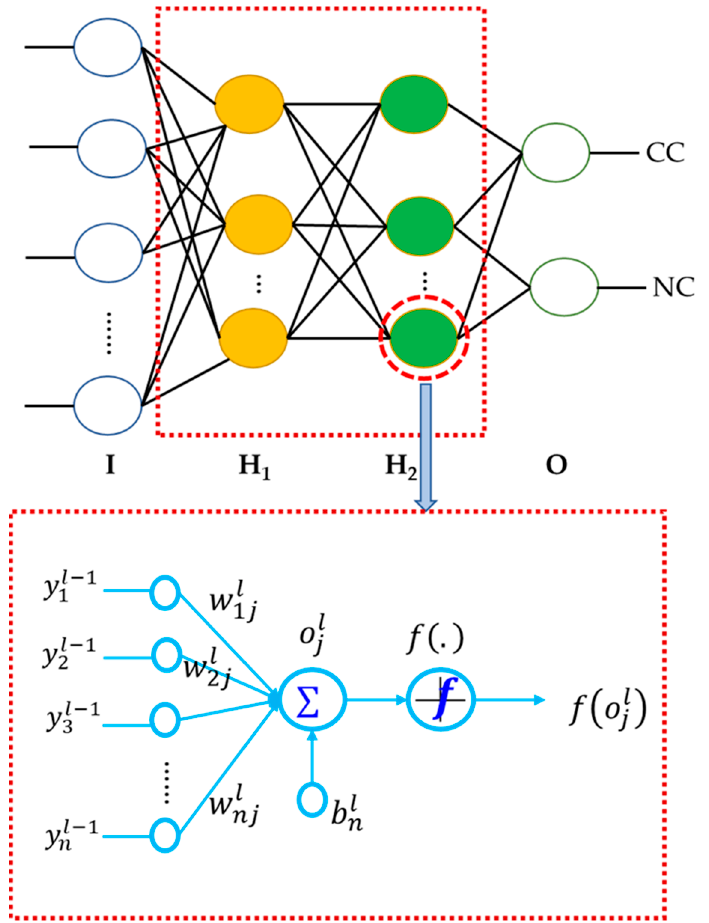
Figure 8. Proposed DNN for identifying pressure vessel cracks. In the figure, I: Input layer, H: Hidden layer, O: Output layer, CC: Crack Condition, NC: Normal Condition, and F: Feature value for the input.